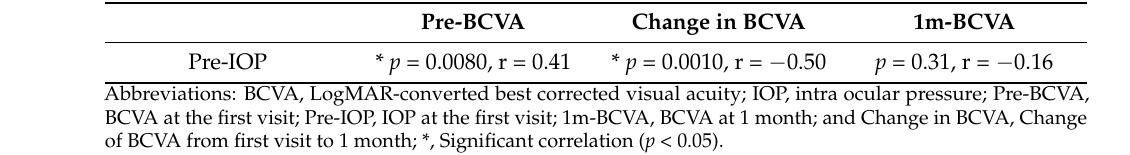
Table 4. Correlation between Pre-IOP and Pre-BCVA, Pre-IOP and 1m-BCVA, and Pre-IOP and Change in BCVA.